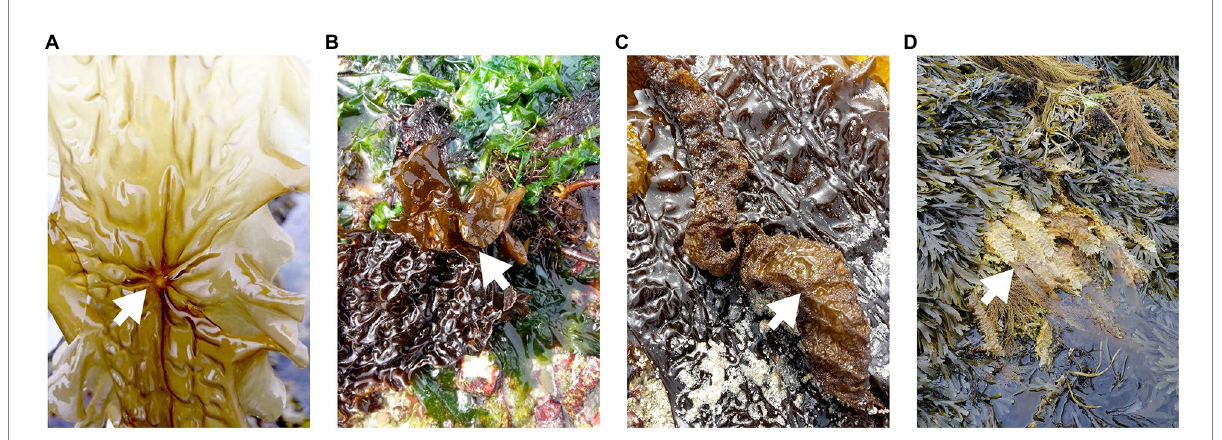
FIGURE 5 Examples of symptoms observed on “diseased” S. latissima individuals. (A) hole, (B) twisted blade, (C) bubbling in blade, and (D) bleaching.